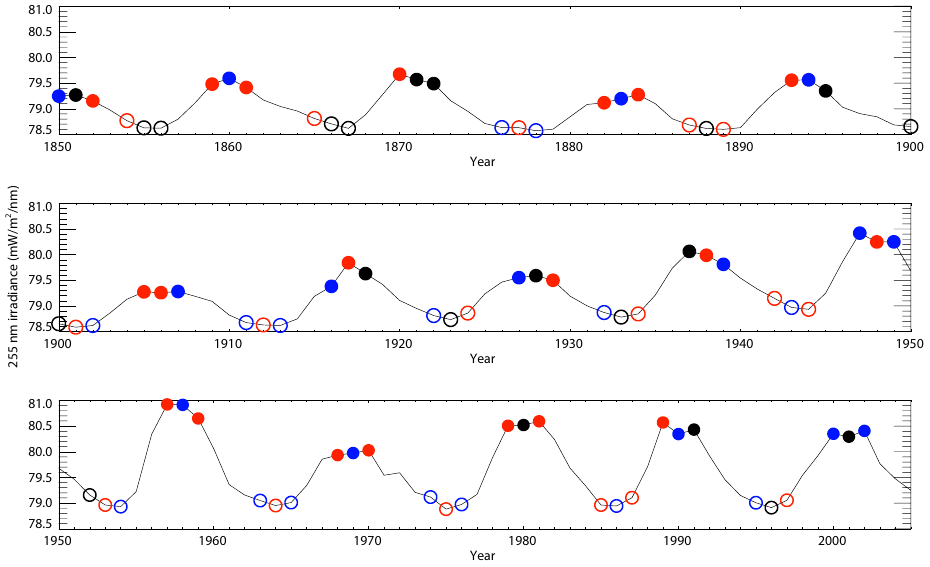
Fig. 2. The annually averaged 255nm spectral irradiance (mWm − 2 nm − 1 ) from Lean et al. (2005) for the periods 1850-1900 (top), 1900– 1950 (middle), and 1950–2005 (bottom). Filled circles represent solar maximum years and open circles represent solar minimum years, determined using a 3year running mean of the annual 255nm spectral irradiance and choosing the 3years that make up a local maximum and minimum for each cycle. Blue colored circles (open and filled) denote years in WACCM4a when the QBO in February (during solar maximum or minimum) was east and red circles when the QBO in February was west. Black open and filled circles denote years when the QBO was neither east nor west using the criteria defined in Sect.